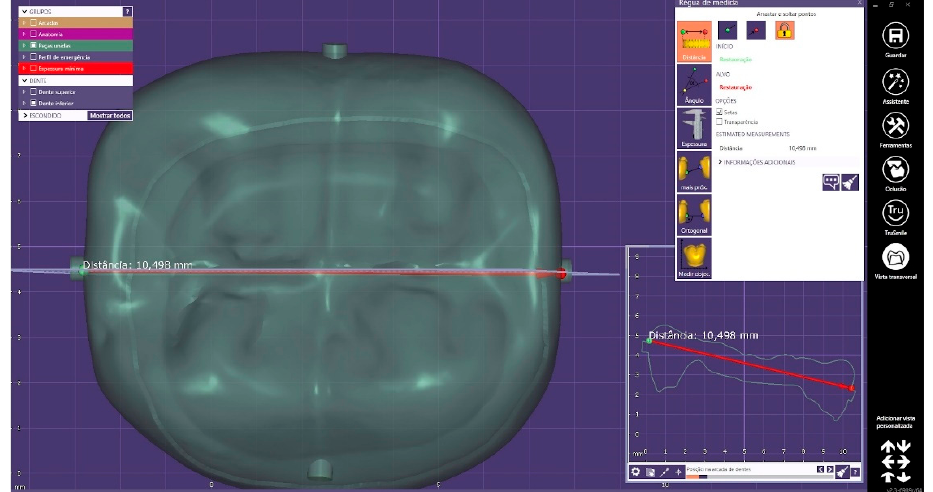
Figure 1. Example of the linear measurement procedure used in this study (dental CAD software, Exocad GmbH). In this example, an STL file of a tooth has 1 mm markers on the 4 axial surfaces (buccal, palatal, mesial, and distal). The figure shows a linear measurement performed between mesial and distal digital markers. Note that since both markers are in different heights, the cross- section view (bottom right) of the CAD software was used to orientate the measurement to be performed between the exact sites that the tips of the digital caliper could touch to make the physical measurements, as performed in the present